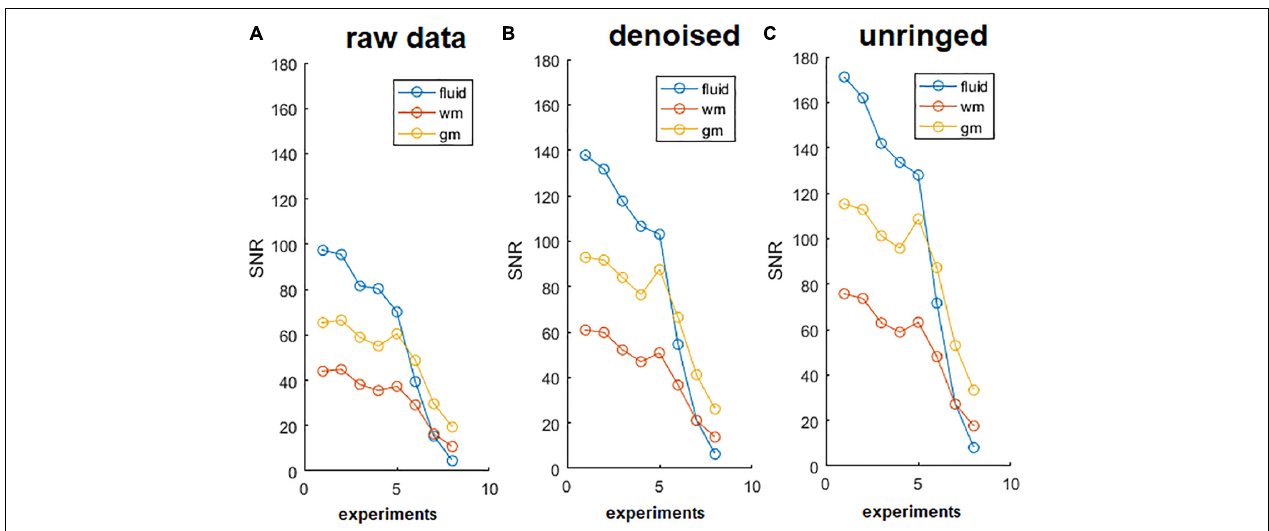
FIGURE 5 | Signal to noise ratio (SNR) of diffusion-weighted images (DWIs). SNR of DWIs collected for α -imaging plotted against the b-values (b0 plus other 7 b-values, in the range 67.9, 1493.6 s/mm 2 ) for DWIs acquired with the diffusion gradient acting along the z (longitudinal) direction with (cid:52) ranging from 40 ms to 800 ms. (A) Raw data, before the noise removal; (B) data after the use of dwidenoise function; (C) data after the removal of Gibbs ringing artifact. SNR computed in the unringed DWIs is the highest for each of the three tissues (fluid = capillary solution; wm = white matter, right column; gm = gray matter, right ventral horn), up to the longest diffusion time. This comparison was made considering the lumbar section of the spinal cord.